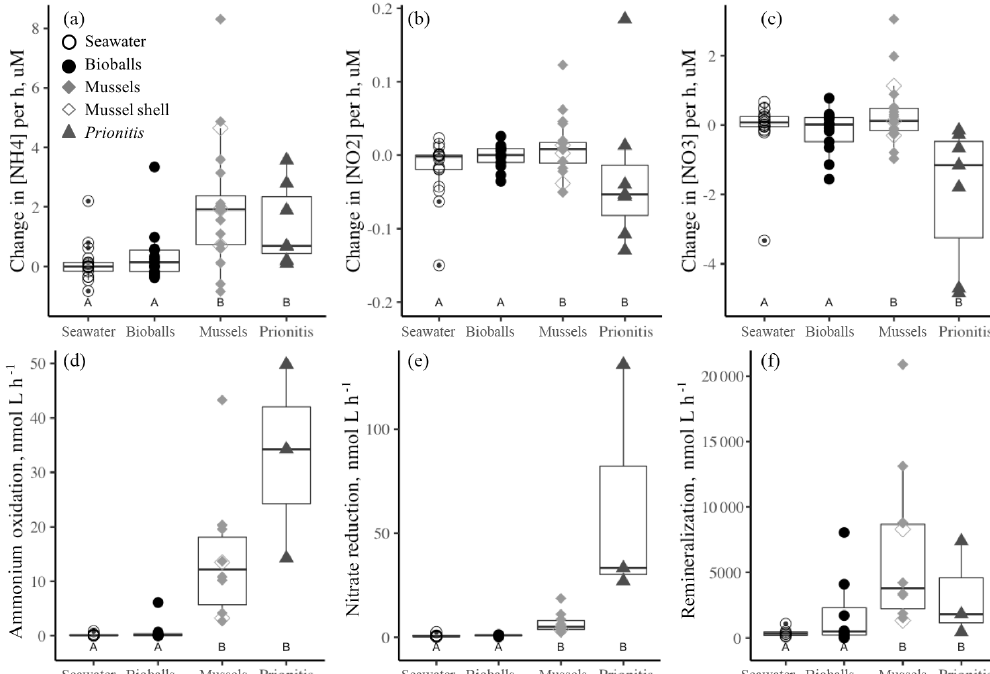
Figure 1. The change in the concentrations of DIN ( a ammonium, b nitrite, c nitrate) in µMh − 1 over the course of daytime experiments when only seawater was present versus the addition of bioballs, mussels, or Prionitis displayed as boxplots. Nitrogen transformation rates (in nmolL − 1 h − 1 ) for (d) ammonium oxidation, (e) nitrate reduction, and (f) the ammonium remineralization rate. Letters indicate statistical differences with ANOVA and Tukey HSD. The box shows 50% of the data, the horizontal line is the median, and the vertical lines represent the first and fourth quartiles. Where vertical lines are absent, they are contained within the boxes. Outliers are shown as individual points outside the vertical lines and are 1.5 times the value beyond the top or bottom of the